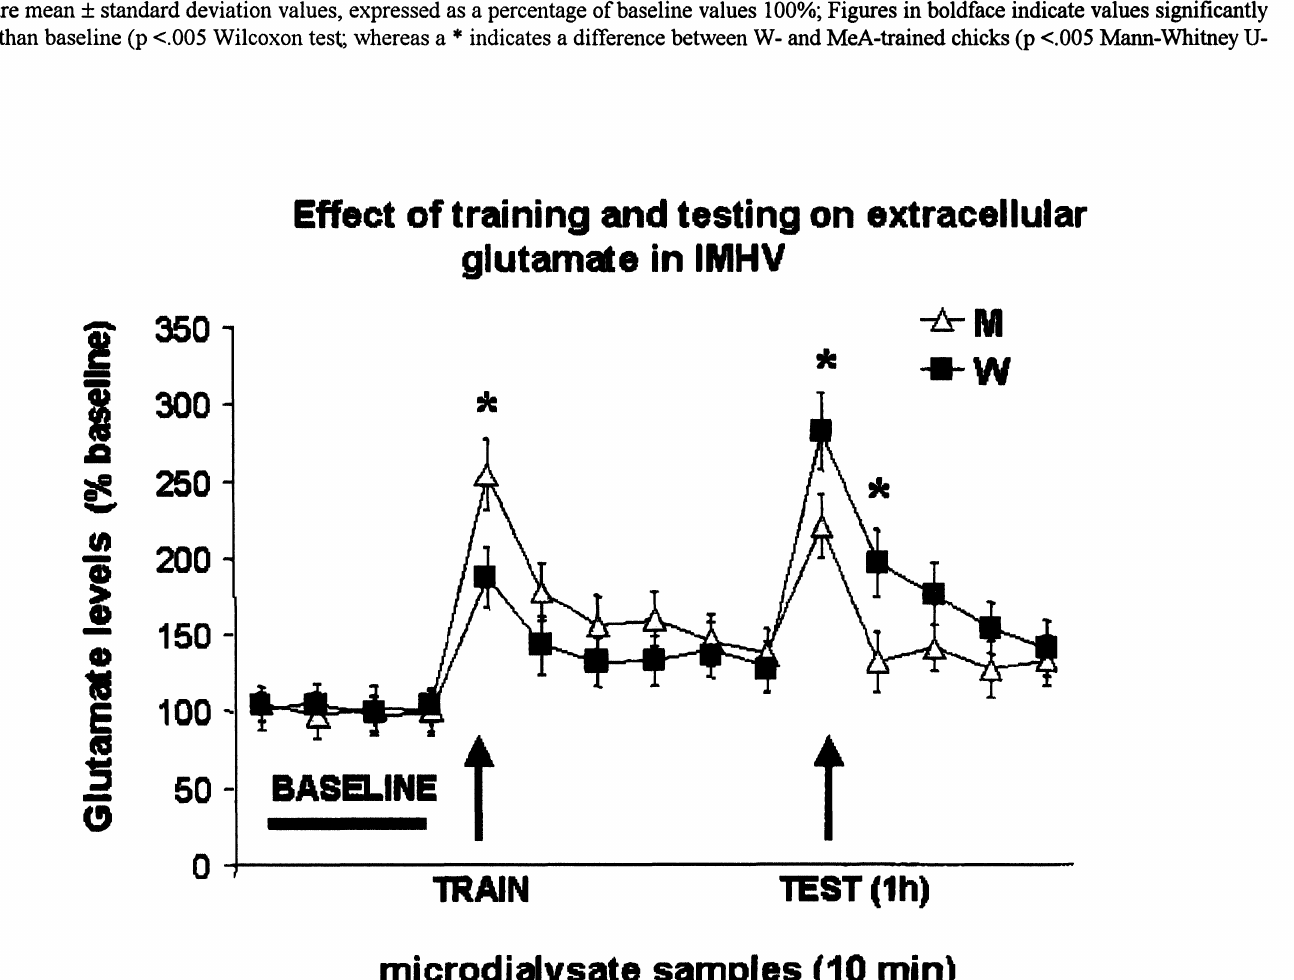
microdialysate samples (10 min) Effect of passive avoidance training and subsequent testing on the extracellular accumulation of glutamate in the left Fig 1: IMHV of MeA- (M) and W-trained (W) chicks. Data are mean +SEM (bars) values. The arrows indicate the dialysate samples, including times ofbead presentation on training and testing. *p <.005 between groups (Mann-Whitney